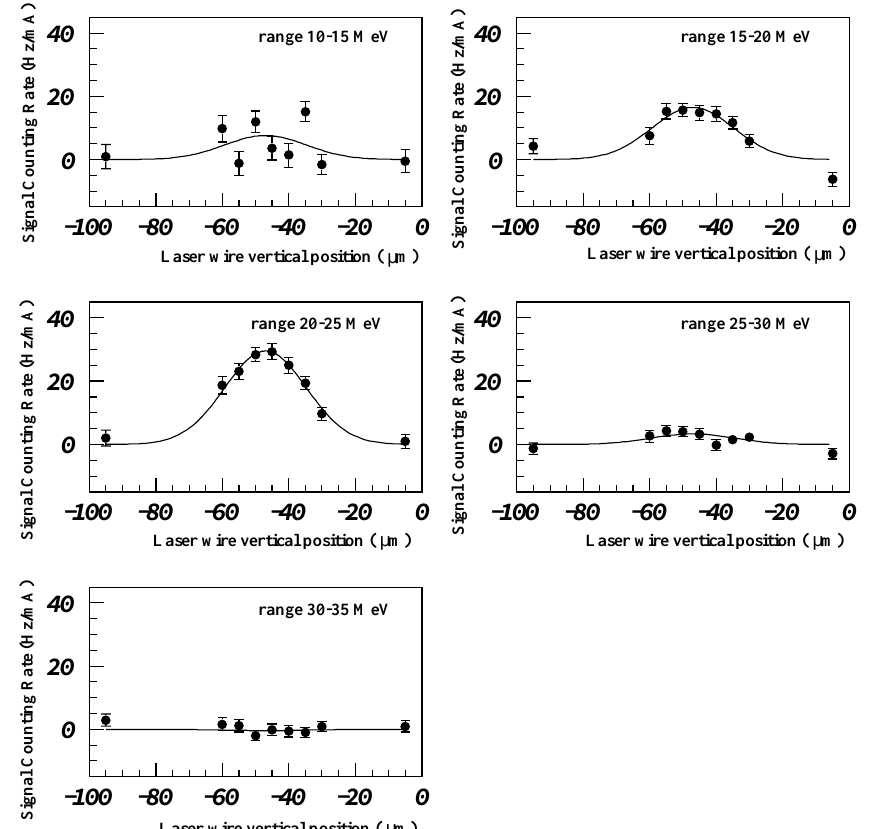
FIG. 4. The signal count rates for five energy intervals as a function of the laser wire vertical position. The solid lines are the Gaussian fits to the data (see the text for detail).